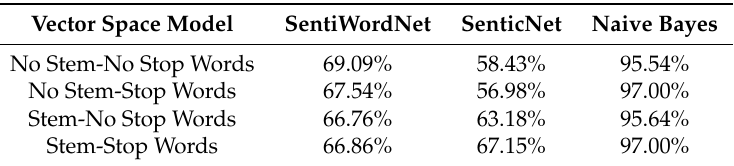
Table 4. Classification rate from the SentiWordNet, SenticNet and naive Bayes techniques for opinion mining: vector space models from the movie training dataset.